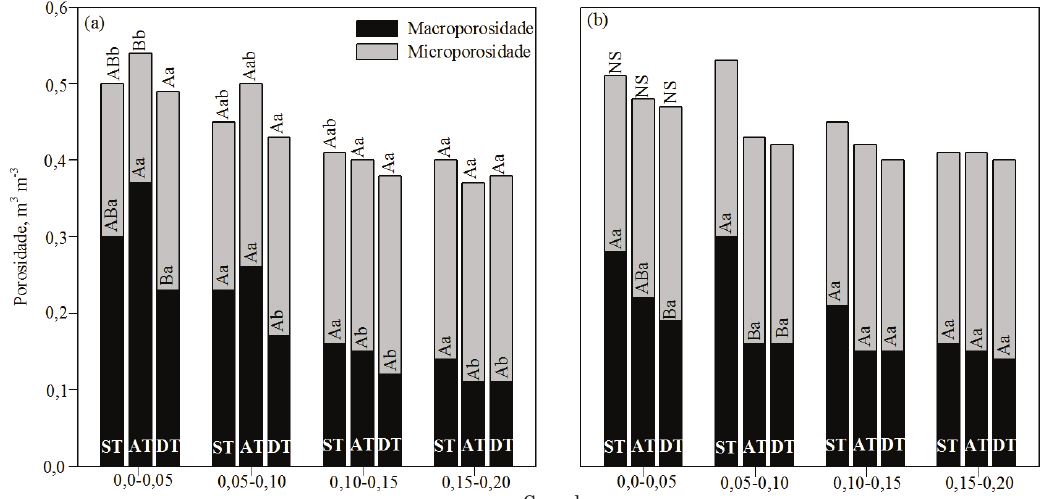
Camada, Figura 2. Porosidade do solo nos sistemas de manejo pousio (a) e aveia mais ervilhaca (b), nas condições de sem tráfego (ST), antes do tráfego (AT) e depois do tráfego (DT), em camadas. Letras iguais não diferem significativamente pelo teste de Tukey (p<0,05). Letras maiúsculas comparam condições de tráfego em cada camada e minúsculas, camadas em cada condição de tráfego.